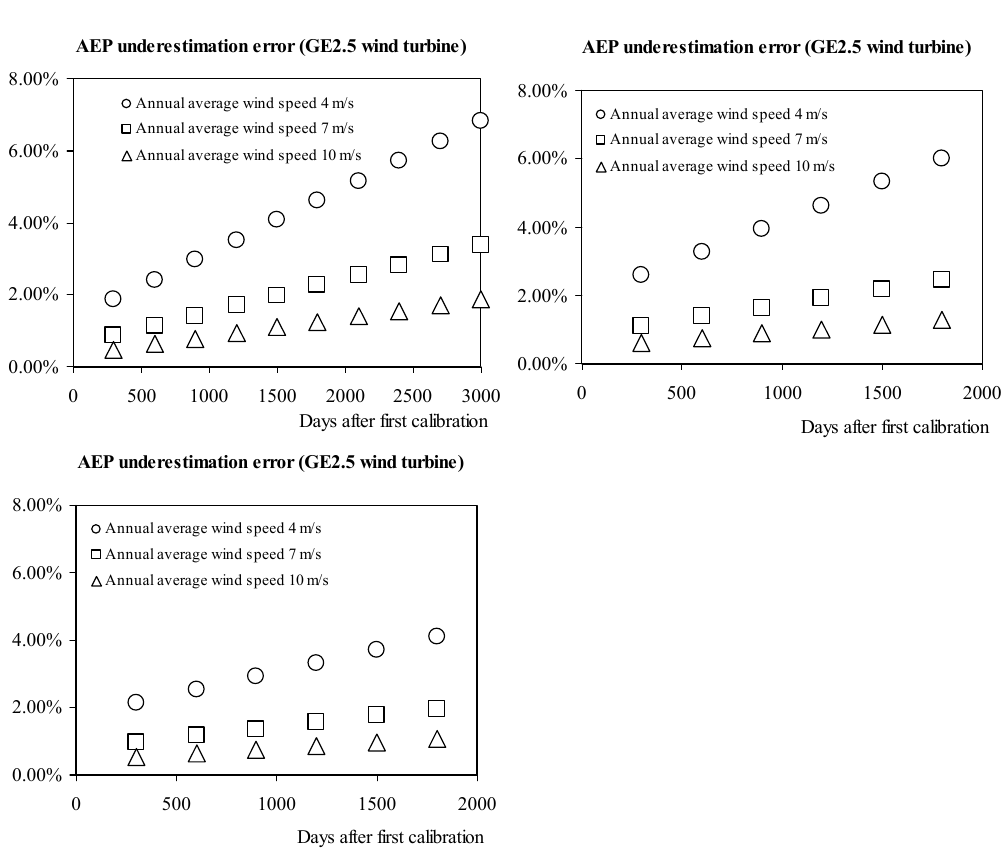
Figure 4. Variation of the Annual Energy Production (AEP) underestimation caused by the error in the wind speed measurement due to the loss of performance of the IDR/UPM Institute’s Cl-100075 (top left side), A100 L2 (top right side), and Th-4.3350 (bottom) cup anemometers. AEP related to General Electric GE2.5. Underestimation calculated with 84.1% confidence level.